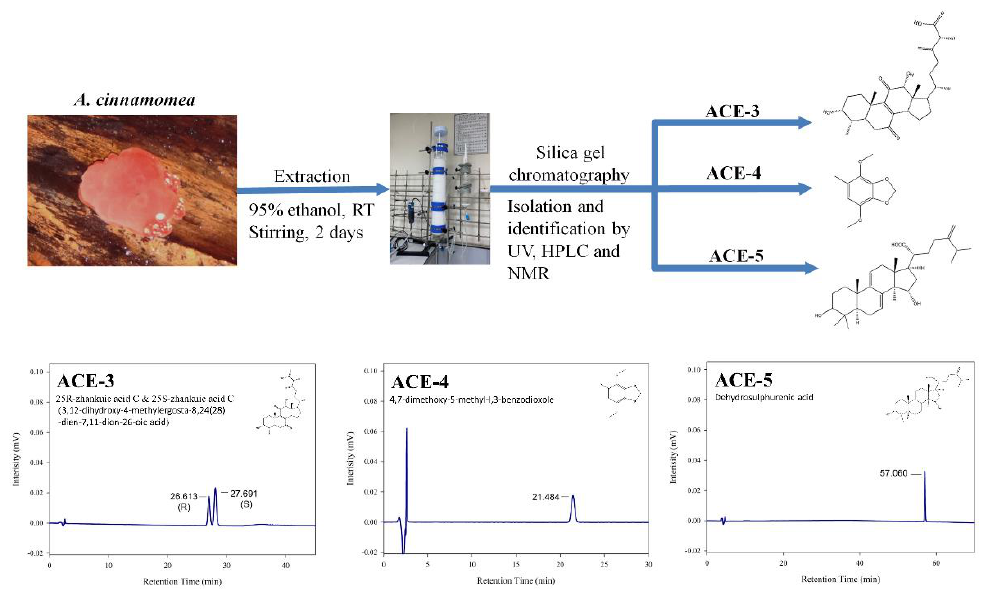
Figure 5. Methods for isolation and identification ofactive compounds from A. cinnamomea .